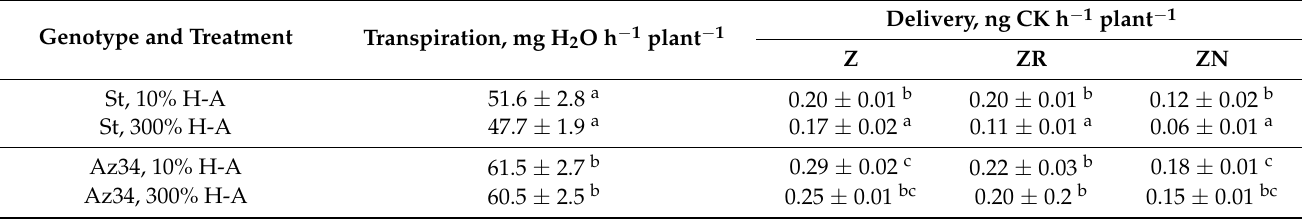
Table 1. Transpiration and cytokinin (CK) delivery from roots to shoot of 6-day-old barley wild type (St) and its ABA- deficient mutant (Az34) growing at 10% of supra-optimal (300%) Hoagland-Arnon solution (H-A).